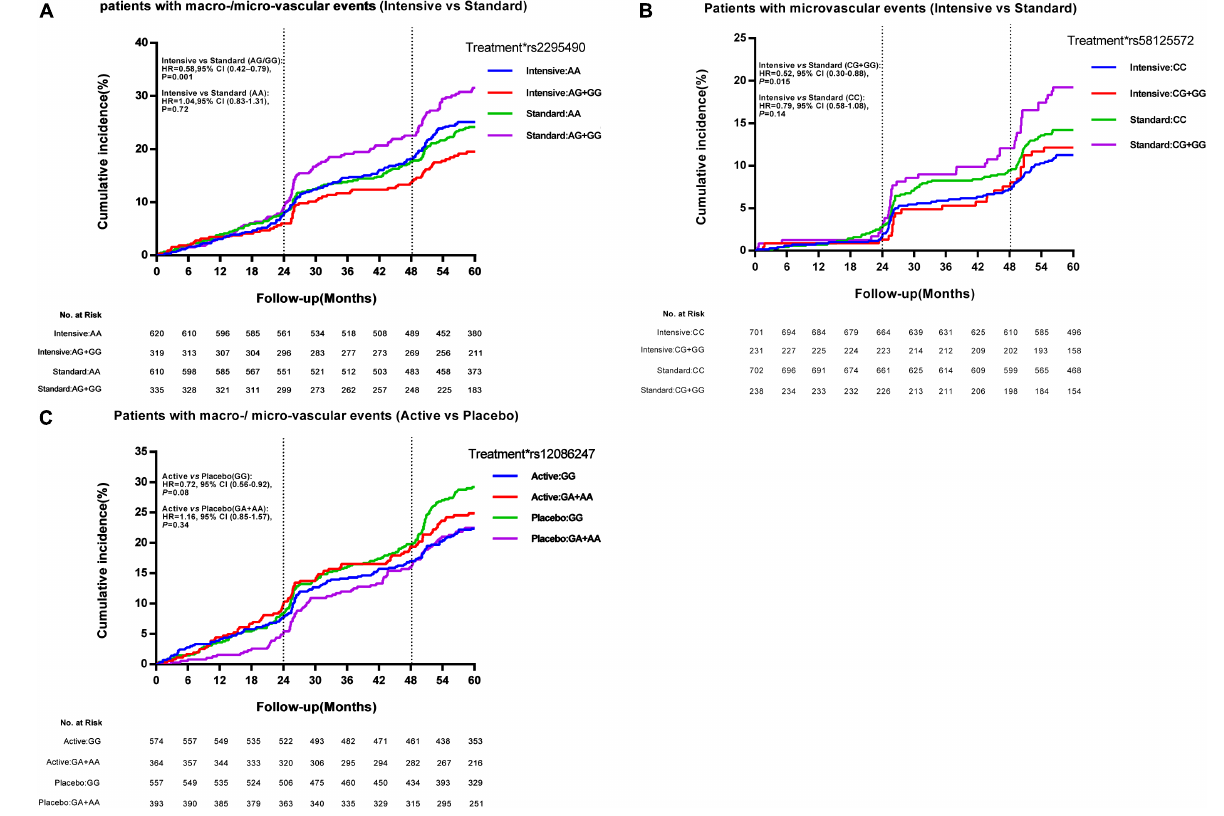
FIGURE 2 | Effect of TRIB3 (rs2295490), SMARCD3 (rs58125572), and ATF6 (rs12086247) genetic variation on primary cardiovascular events. Panels (A–C) depict the positive effect of TRIB3 , SMARCD3 , and ATF6 genetic variants on the cumulative incidence of major vascular events according to glucose control or blood pressure-lowering treatment. The vertical dotted line represents additional data on microvascular events collected at the 24-month and 48-month study visits. The time to event was recorded as the date of visit. At month 57, 99% of events had occurred and the curves were truncated. The effects of the genetic variations were analyzed using unadjusted Cox proportional hazards